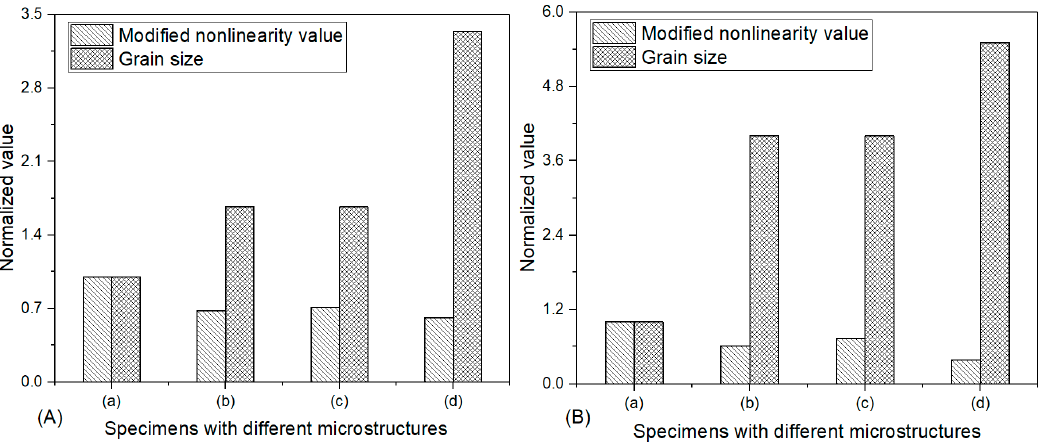
Figure 9. Variations of acoustic nonlinear response ( 𝛽̅ (cid:3030) ) in ( A ) copper and ( B ) brass with different microstructures.